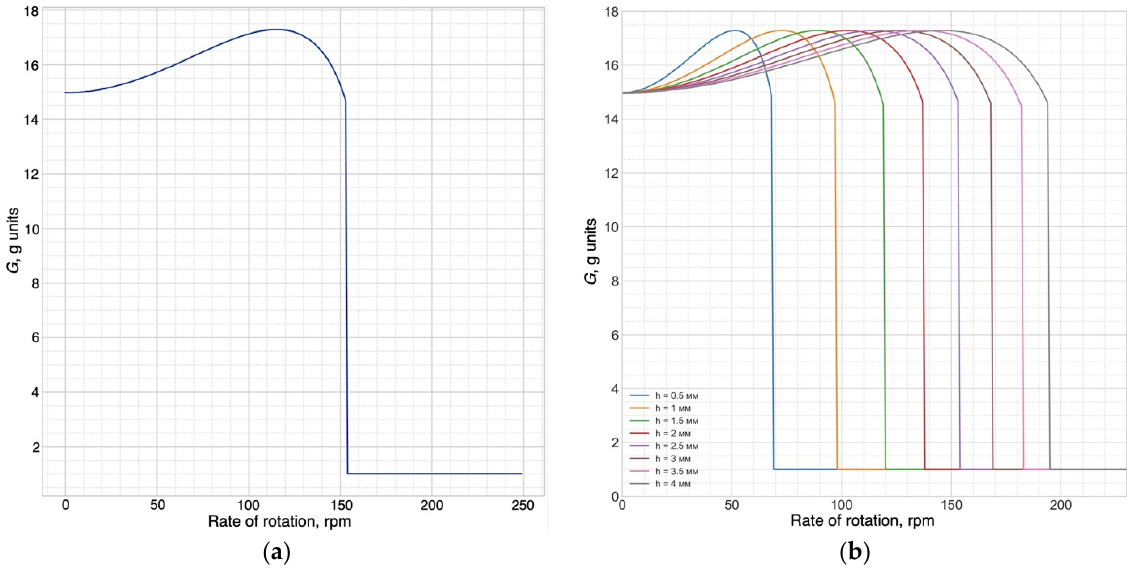
Figure 12. Nomograms: ( a )—rate of rotation–G relation; ( b )—axial and lateral shocks–rate of rotation relation from the cutting depth of sandstone.